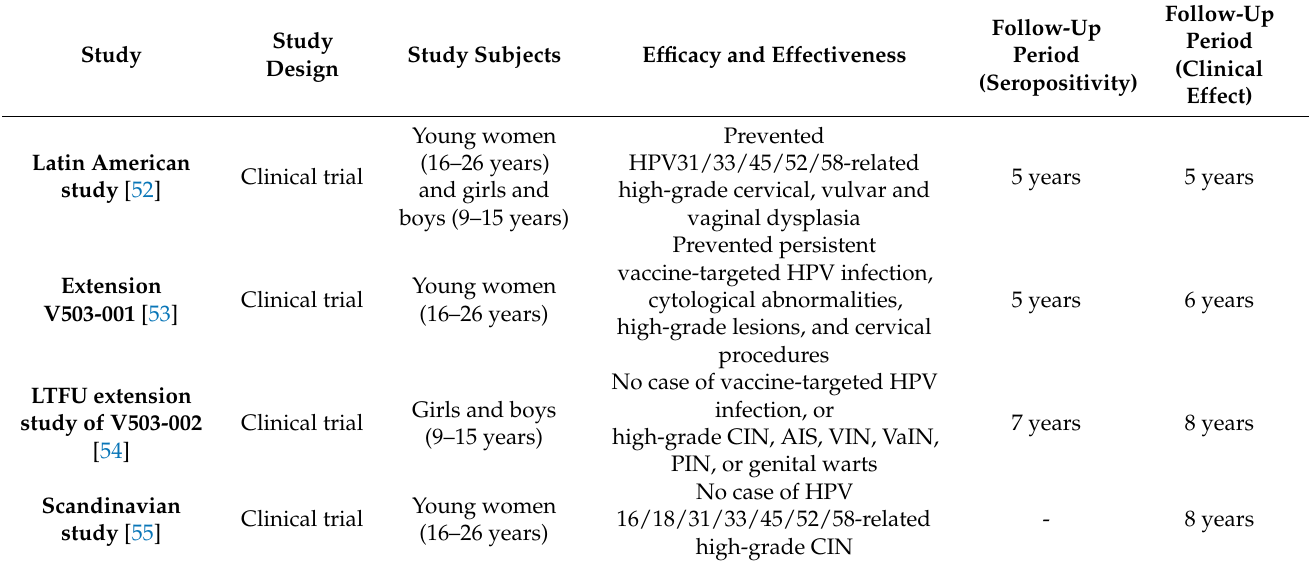
Table 4. Long-term effect on 9-valent